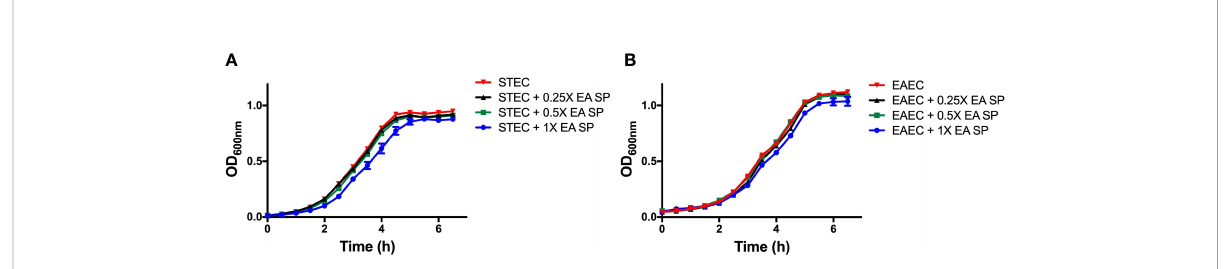
FIGURE 5 STEC and EAEC growth curve in the presence of different concentrations of EA SP. Overnight cultures from STEC (A) and EAEC (B) were diluted in DMEM HG medium with different concentrations of EA SP. These bacteria were grown for 6 h at 37°C and optical density at 600 nm (OD 600nm ) was measured every 30 min. Results are expressed as the means ± the standard errors for one of three experiments done in triplicate. Difference between groups were tested by ANOVA and multiple comparison test.